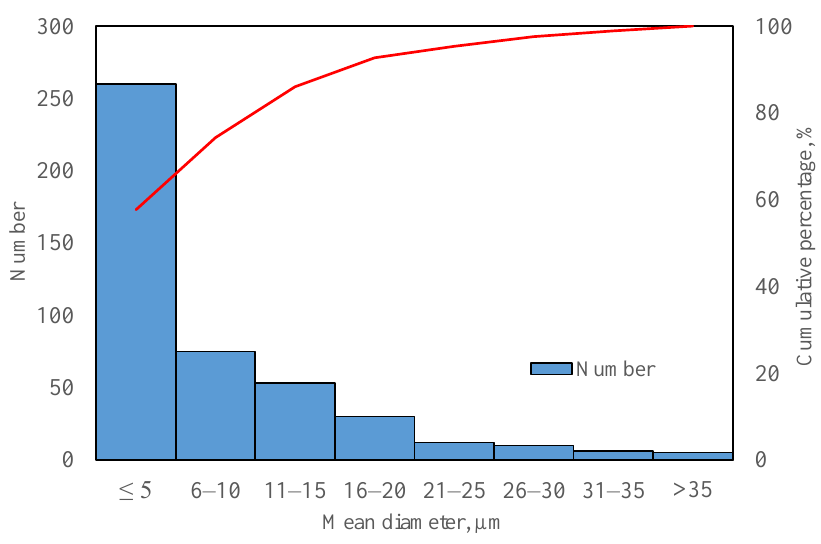
Figure 4. Pore size distribution in SLM samples, obtained from optical microscopy. Red curve represents the cumulative pore distribution.